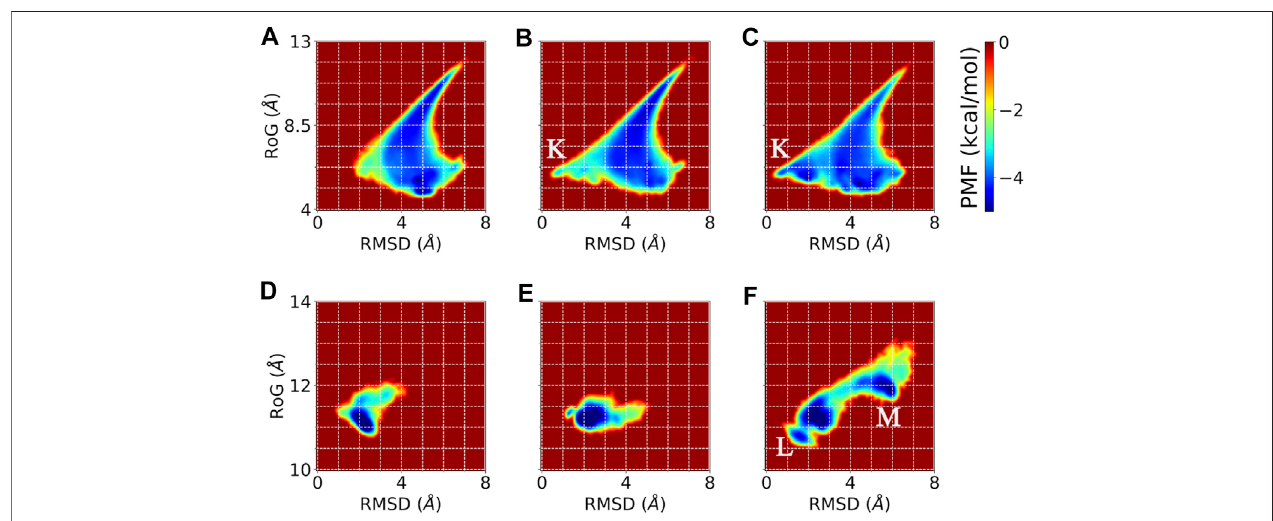
FIGURE8| Potentialsofmeanforce(PMF)showingthedistributionofthesampledconformationsbyconventionalMD,acceleratedMD,andDESPMDsimulations of A 12 (top) and GB98 (bottom) molecular systems. Reweighting has been done wherever necessary. Comparison using PMF based on physically meaningful collective variables,namely,therootmeansquaredeviationfromaknownexperimental/initialstructure(RMSD)andtheradiusofgyration(RoG)areshownforconventional (Aand D) , accelerated (B and E) , and DESP (C and F) MD simulations for the A 12 (top/A, B, C) and the GB98 (bottom/D, E, F) molecular systems. Overall, one would notice that the rightmost panels (C and D) show wider and more diverse regions visited by the molecular system, which means that the DESP can explore more conformation spaces than either the conventional (A and B) or the accelerated (B and E) MD simulations for these collective variables. The regions with stable conformations sampled by both DESP and accelerated MD simulations but not sampled by the conventional MD simulations are marked with “ K, ” while the regions sampled by DESP alone but not sampled by either the conventional or the accelerated MD simulations are marked with “ L ” and “ M.